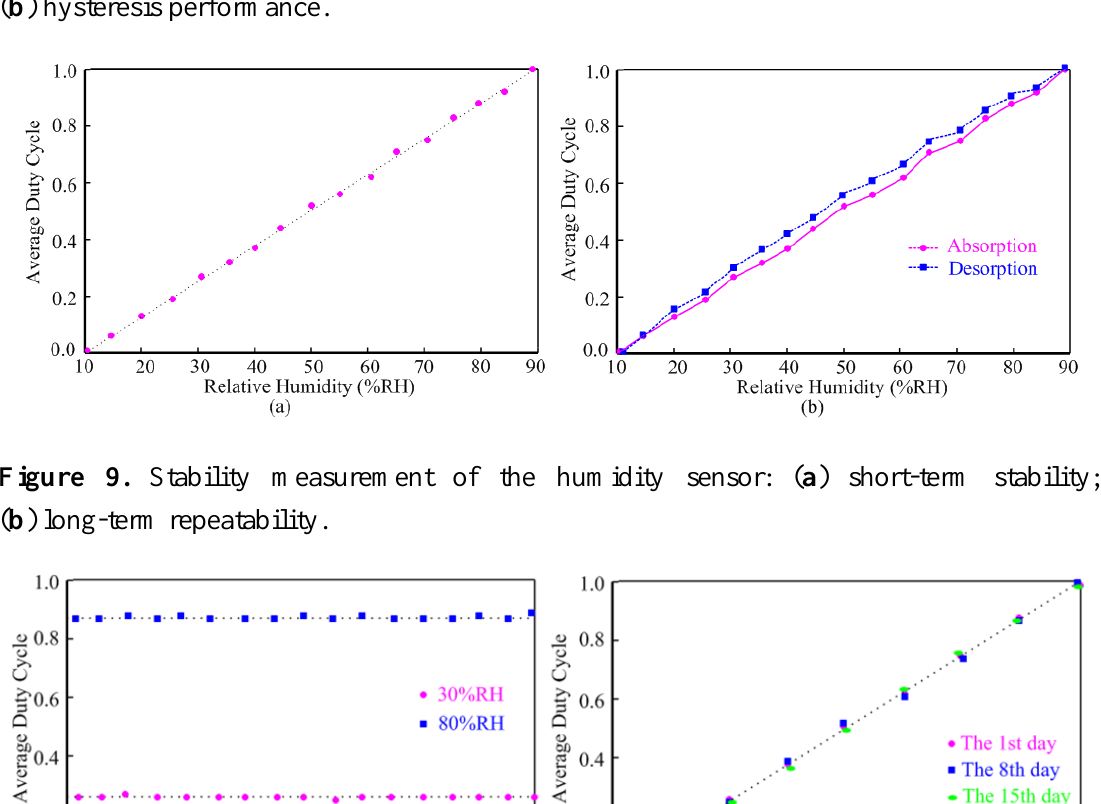
Figure 8. Sensitivity measurements of the humidity sensor: ( a ) linearity performance; ( b ) hysteresis performance.